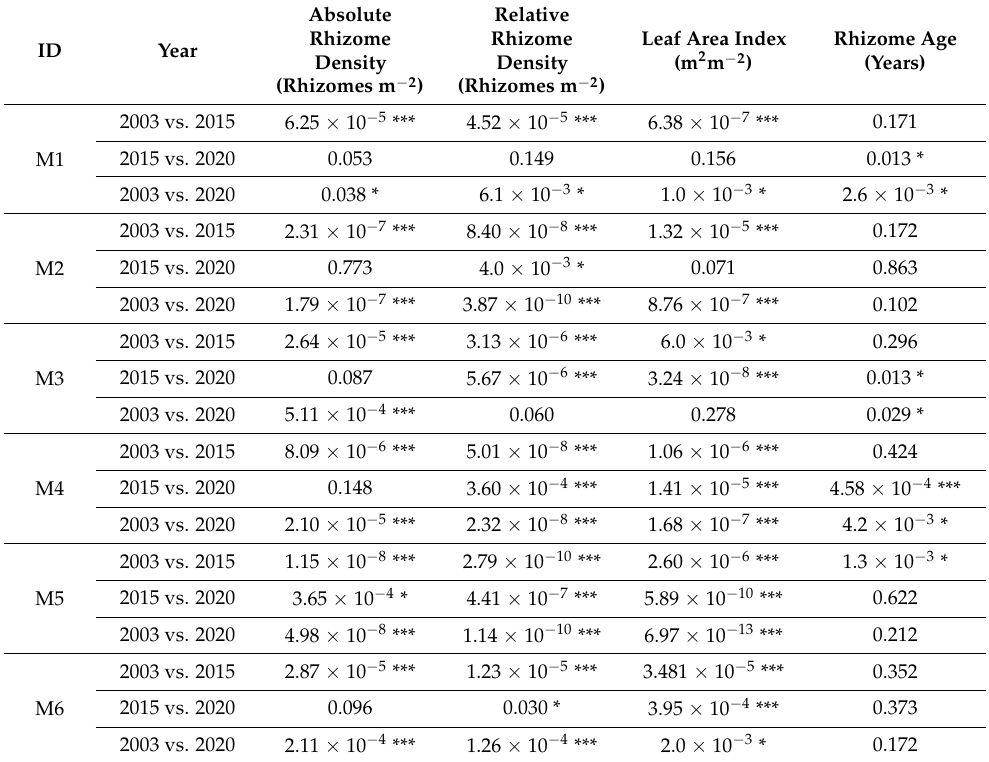
Table 3. Differences in p -values ( t -test) between different years of monitoring within each sam- pling